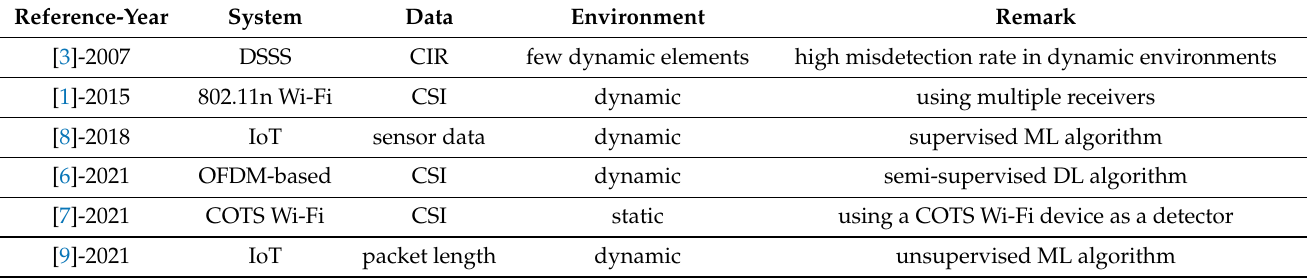
Table 1. A comparison of the relevant